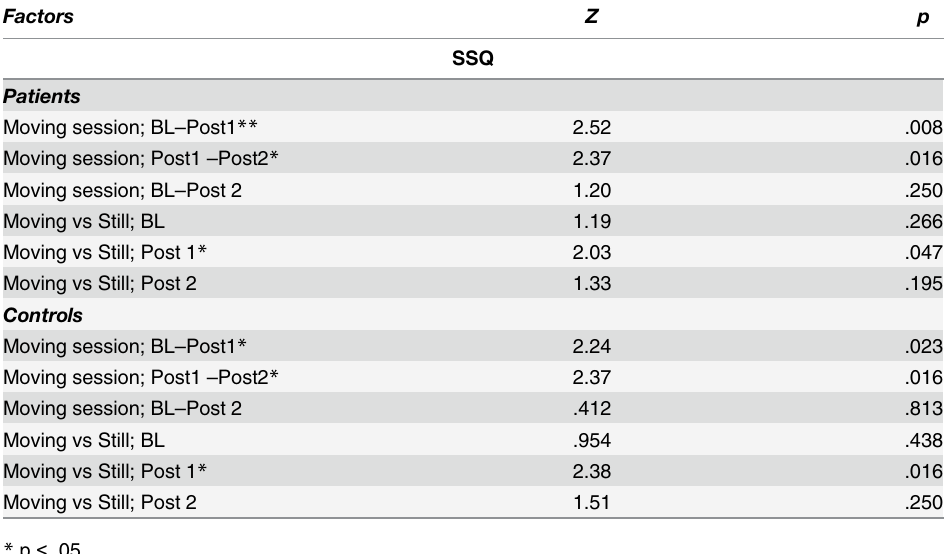
Table 5. Wilcoxon signed rank tests as a follow-up for significant Friedman tests for the SS